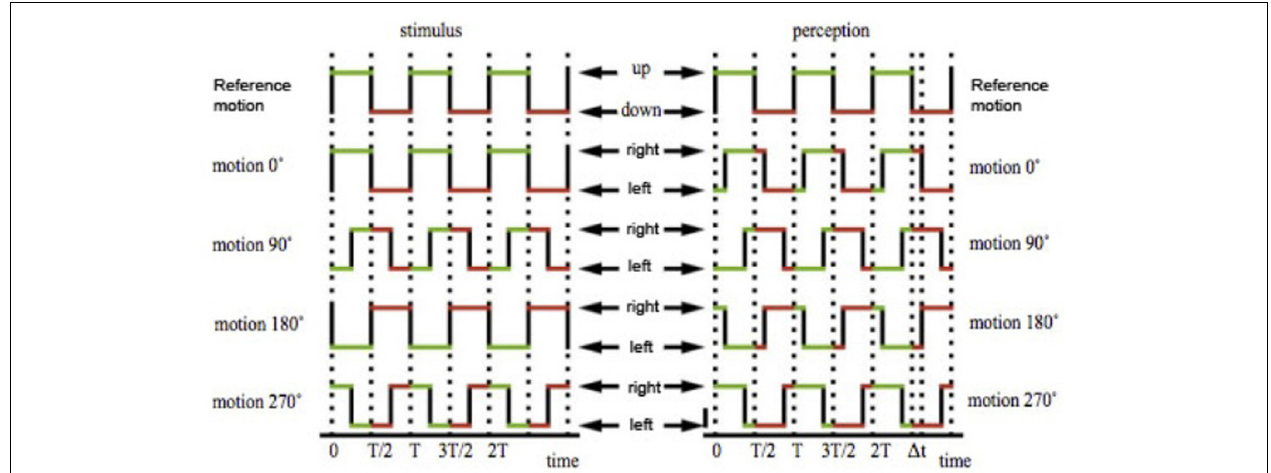
FIGURE 3 | The directions of motion of the small squares are described by two square wave oscillations, both with a period of 833 ms. The test stimulus was shifted against the reference stimulus by a variable phase offset, ranging from 0 to 324 ◦ , in 10 steps of 36 ◦ . In temporal terms, each interval represents 83.3 ms, a tenth of a total period of 833 ms. With a 0 ◦ offset, the up phase of the reference stimulus will completely coincide with the right phase of the test stimulus. With a 180 ◦ offset, the up phase of the reference stimulus will